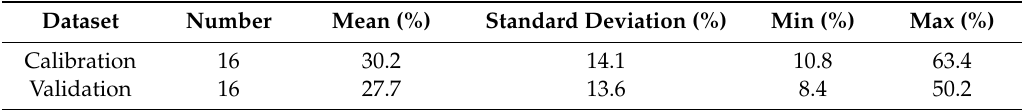
Figure 2. HyMap imagery ( A ) and soil mask ( B ) in the study area Cabo de Gata-Nijar. The locations of field samples were shown in green squares. Table 1. Statistics of soil clay content for the calibration and validation